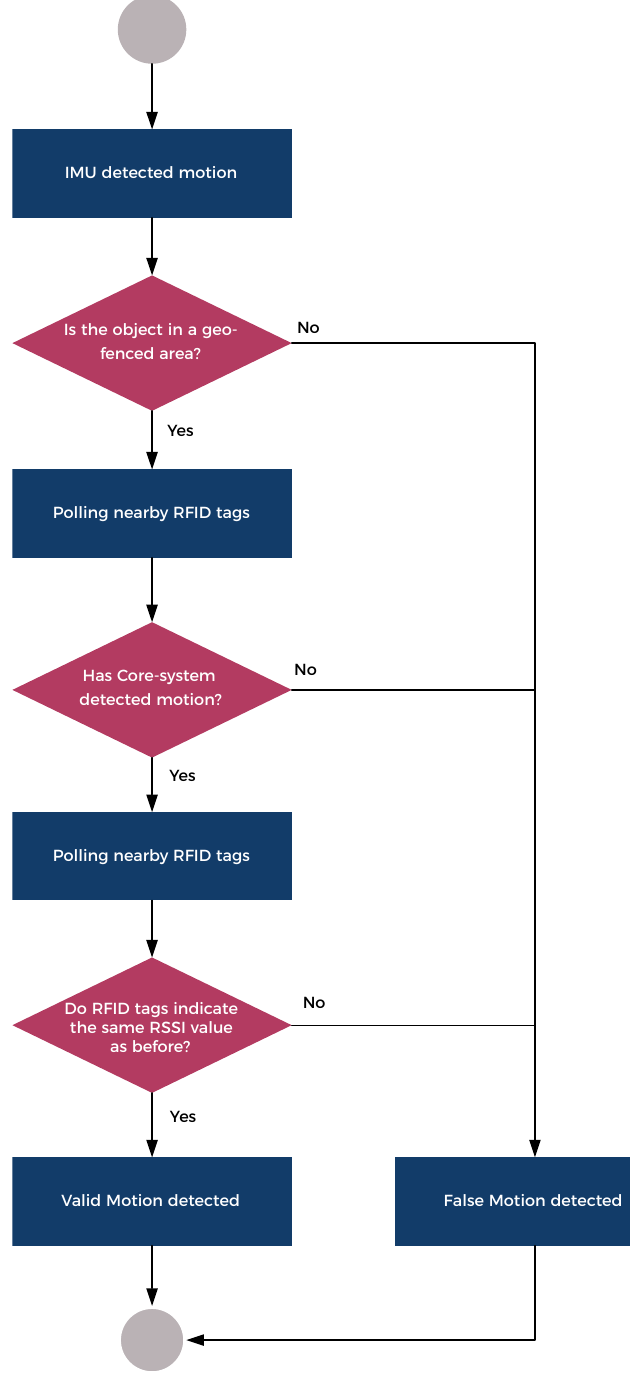
Figure 6. Detection tree of a START